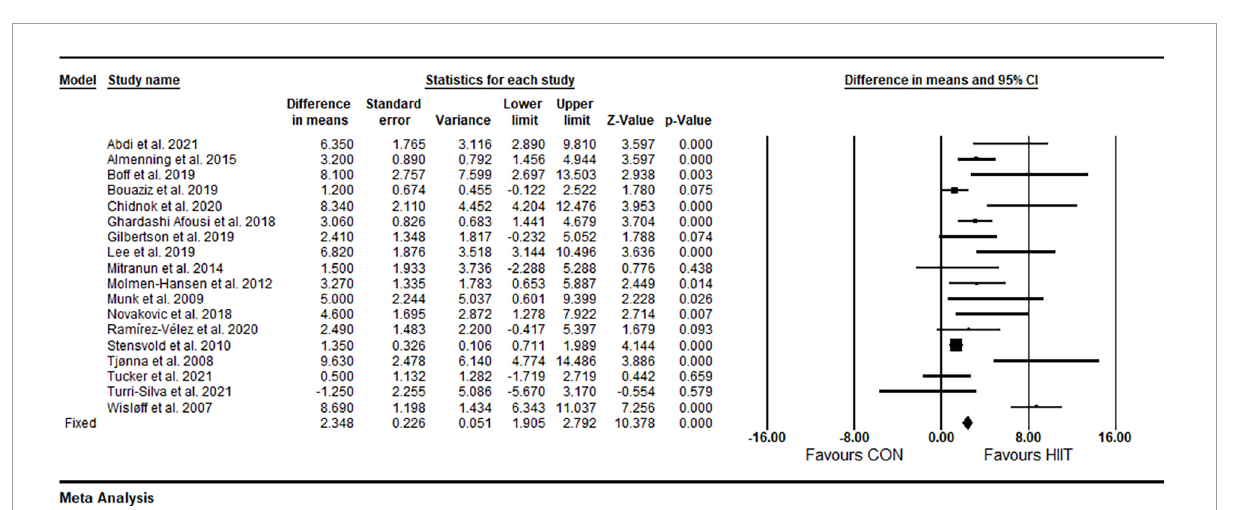
FIGURE3 Forest plot of the effects of HIIT vs. CON on FMD. Data are reported as WMD (95% confidence limits). FMD, brachial artery flow-mediated dilation; WMD,: weighted mean